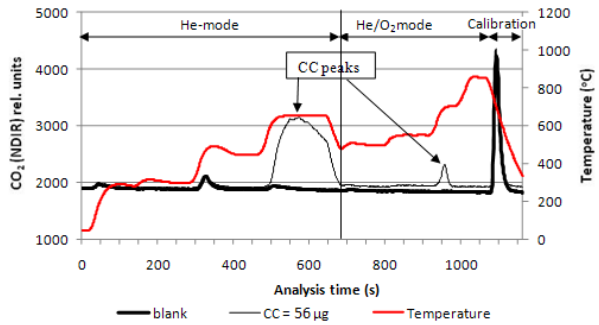
Fig. 5. EUSAAR 2 thermogram for a blank and a CC-loaded filter (56µg) (He-mode: 1–230s, He/O 2 -mode: 231–410s and Calibration-mode: 410–510s). The vertical lines represents the splint point between OC and EC. The response of the NDIR de- tector is given in relative units.